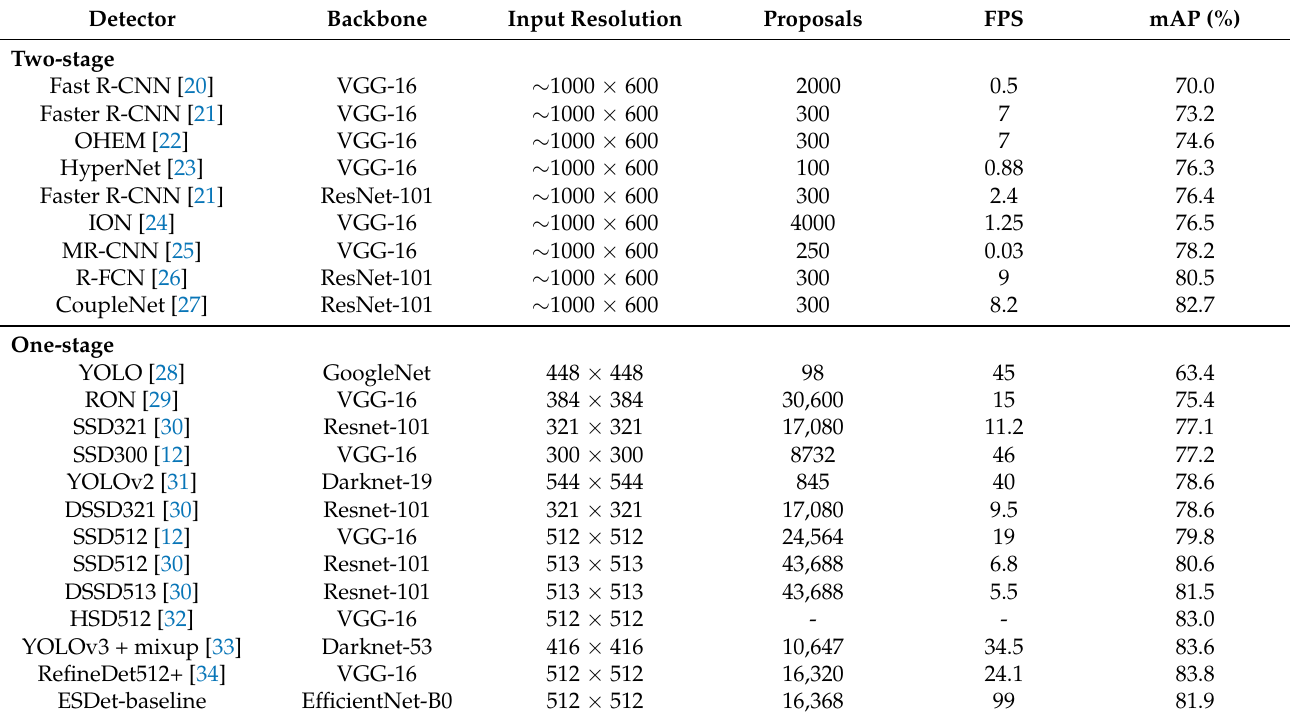
Table 4. Detection results on PASCAL VOC 07 test data set. All networks were trained using VOC 07 and VOC 12 train sets.